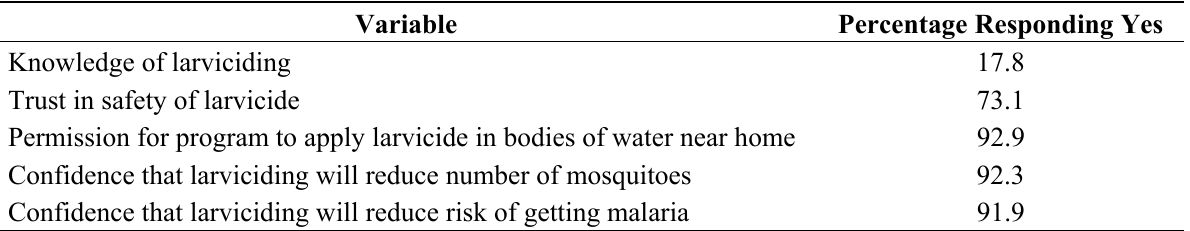
Table 3. Household attitudes towards larviciding: Dichotomous responses.